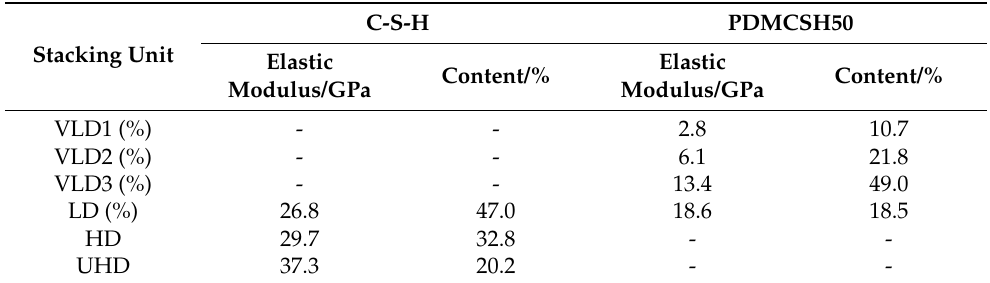
Table 1. Probability density distributions of elastic modulus of PDMCSH00 and